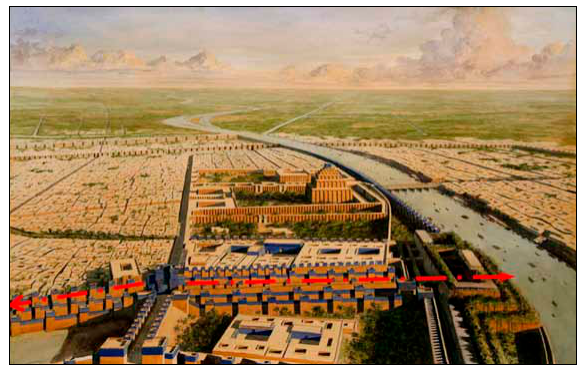
fig. 3. Main processional street ( Aj-ibur-shapu ) towards Ishtar Gate in Babylon. Sources : Modified from: http://www.cristoraul. com/EnGlISH/The-Book-of-History/Volume-1/32-rISE-of-